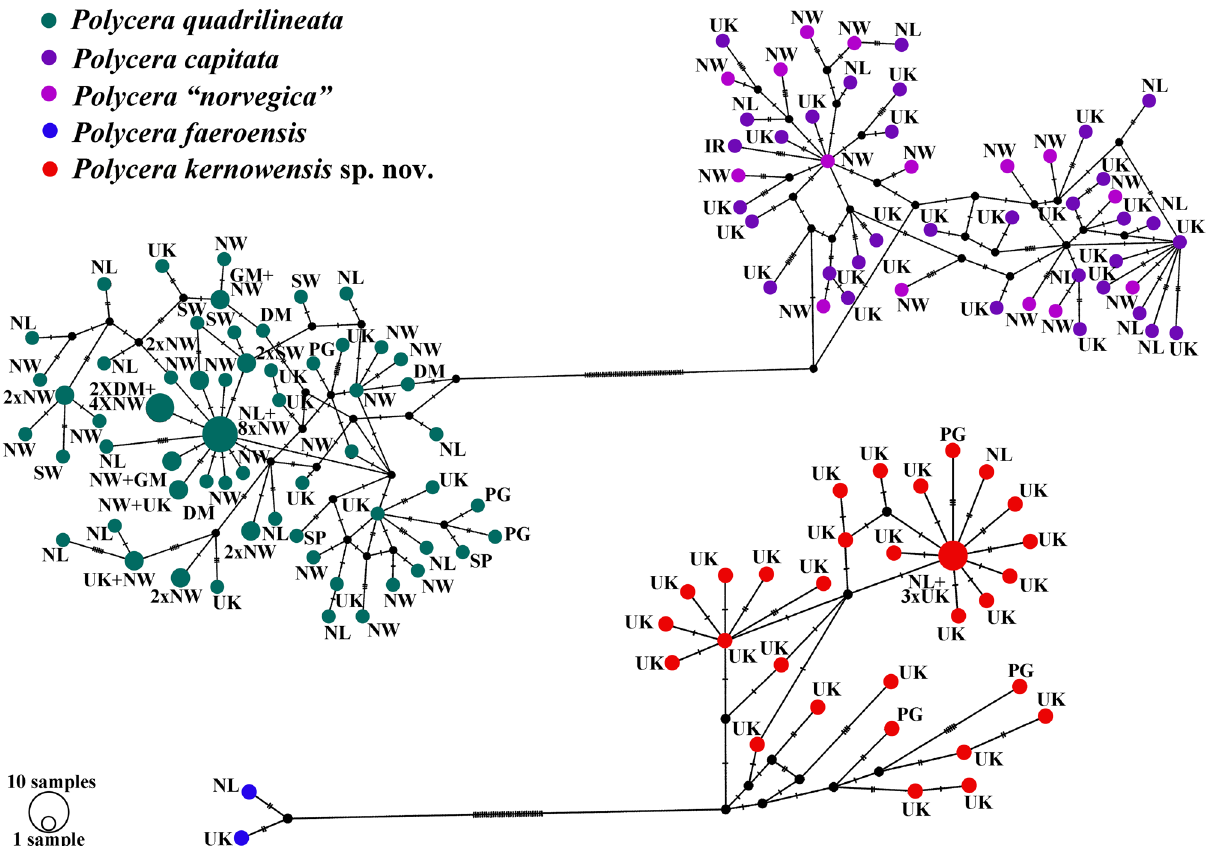
Figure 4. The haplotype network for Polycera specimens based on cytochrome c oxidase subunit I (COI) molecular data (642 bp). Phylogeographic data are represented within a broad geographic framework. Each circle represents one haplotype, the circle area indicates the occurrence rate. Each cluster (species) is coloured individually ( P. quadrilineata in green, P. capitata in purple, “ P. norvegica ” in pink, P. faeroensis in blue and P. kernowensis sp. nov. in red.). DM Denmark, GM Germany, IR Ireland, NL Netherlands, NW Norway, PG Portugal, SP Spain, SW Sweden, UK United distribution of each of the four species from this complex, P. capitata and “ P. norvegica ” recently described from Norway have a widespread distribution in England, Ireland and Norway, and do not show separate clustering. Regarding the supposedly fast-evolving COI marker, uncorrected p-distances within the P. quadrilineata clade range 0–3.36%. Whereas minimal uncorrected p-distances between the P. quadriline- ata clade and P. capitata (combined with P. norvegica), P. faeroensis , and P. kernowensis sp. nov. clades are 9.44%, 11.09%, and 10.79% respectively. Uncorrected COI p-distances within the P. capitata (combined with P. norvegica) clade range from 0.15 to 3.04%. Minimal uncorrected p-distances between the P. capi- tata (combined with P. norvegica ) clade and P. faeroensis , and P. kernowensis sp. nov. clades are 8.52%, and 8.66% respectively. Uncorrected COI p-distances within the P. faeroensis clade are 0.61%; within the P. kernowensis sp. nov. clade range 0–2.33%. Uncorrected COI p-distances between P. faeroensis and P. kernowensis sp. nov. clades range from 5.47 to 6.38% (Table 2). Polycera aurantiomarginata García-Gómez & Bobo, 1984, which was described from Spain and which is also distributed on the West African coasts 22 belongs to a different Polycera clade, considerably differ- ent morphologically, and hence is not part of the complex of the European species closely related to P. quadrilineata. Therefore P. aurantiomarginata is included in the present molecular phylogenetic analysis,